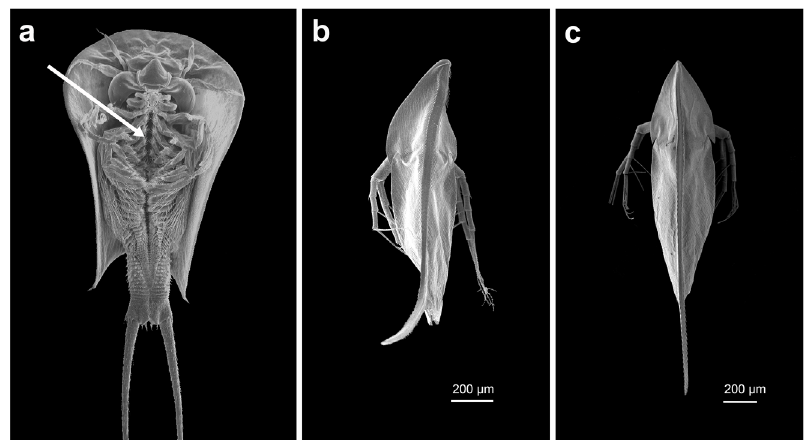
Fig 1. Scanning electron microscope images of the experimental animals. a) Triops cancriformis , ventral view with the arrow pinpointing to the narrow food groove. The ancient predator feeds on Daphnia , which are caught, subsequently placed into the food groove and transported towards the mandibles; b) Dorsal view of a Triops -exposed morph of Daphnia barbata showing the “ twisted ” appearance. The tips of helmet and tail spine deviate from the body axis in opposite directions, leading to an S-shaped dorsal ridge and thus abolishing bilateral symmetry of the individual. The twisted morphotype can be assumed to severely impede the transport through the food groove as it should cause the daphnid to wedge within the food groove of the predator. c) Dorsal view of D . barbata not exposed to the predator. The dorsal ridge aligns with the bilateral body axis, the tips of helmet and tail spine do not deviate from the body